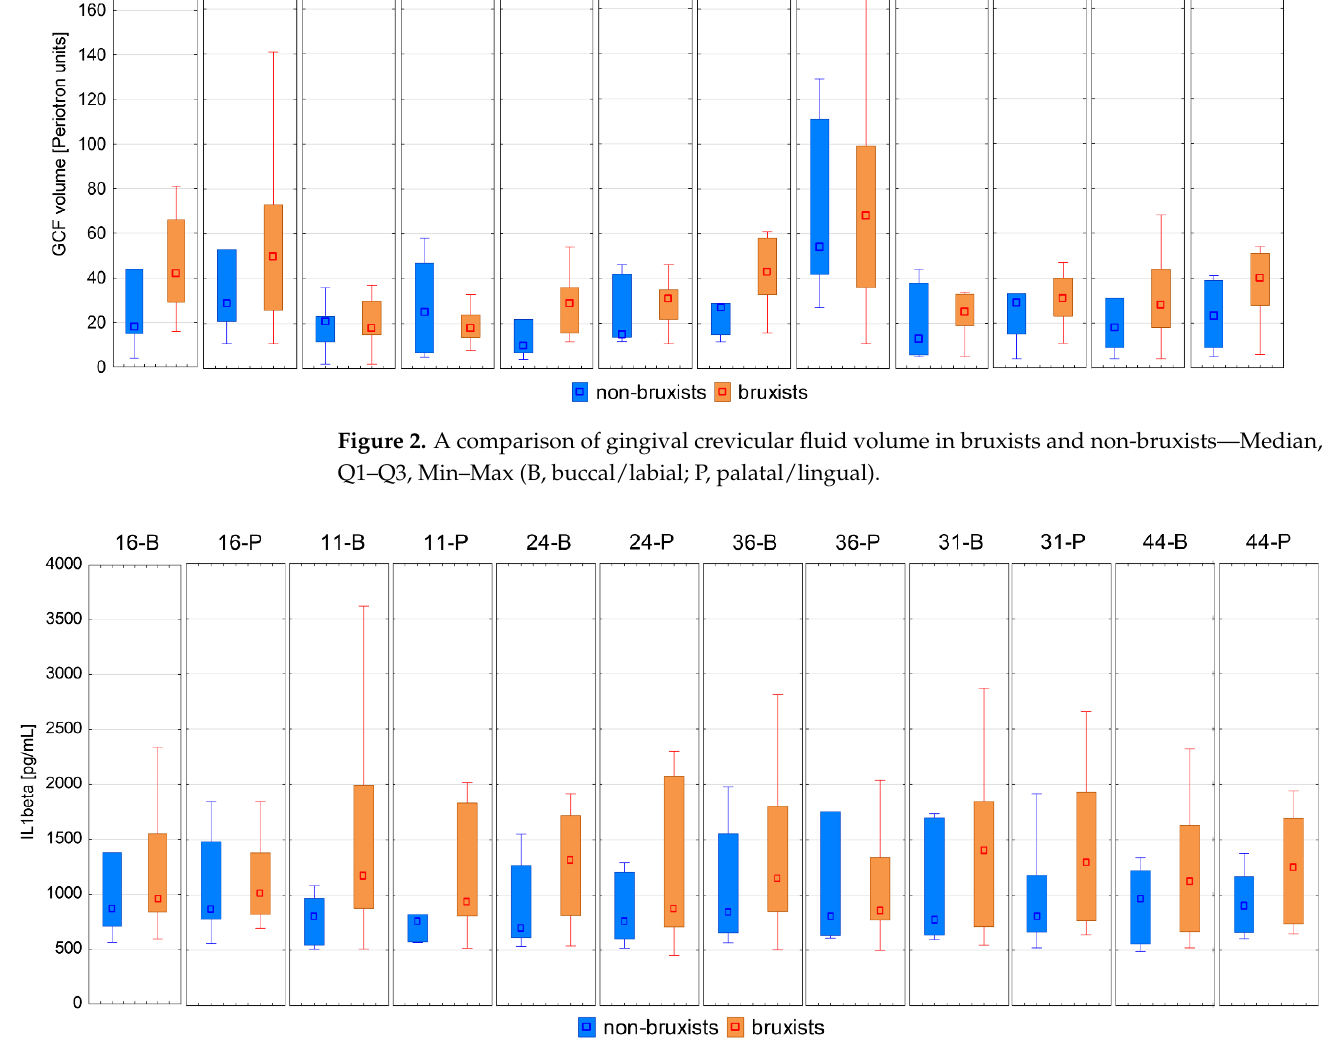
Figure 3. A comparison of interleukin-1 β concentration in bruxists and non-bruxists — Median, Q1 – Q3, Min – Max (B, buccal/labial; P, palatal/lingual). Table 3. Results comparing bruxists and non-bruxists.